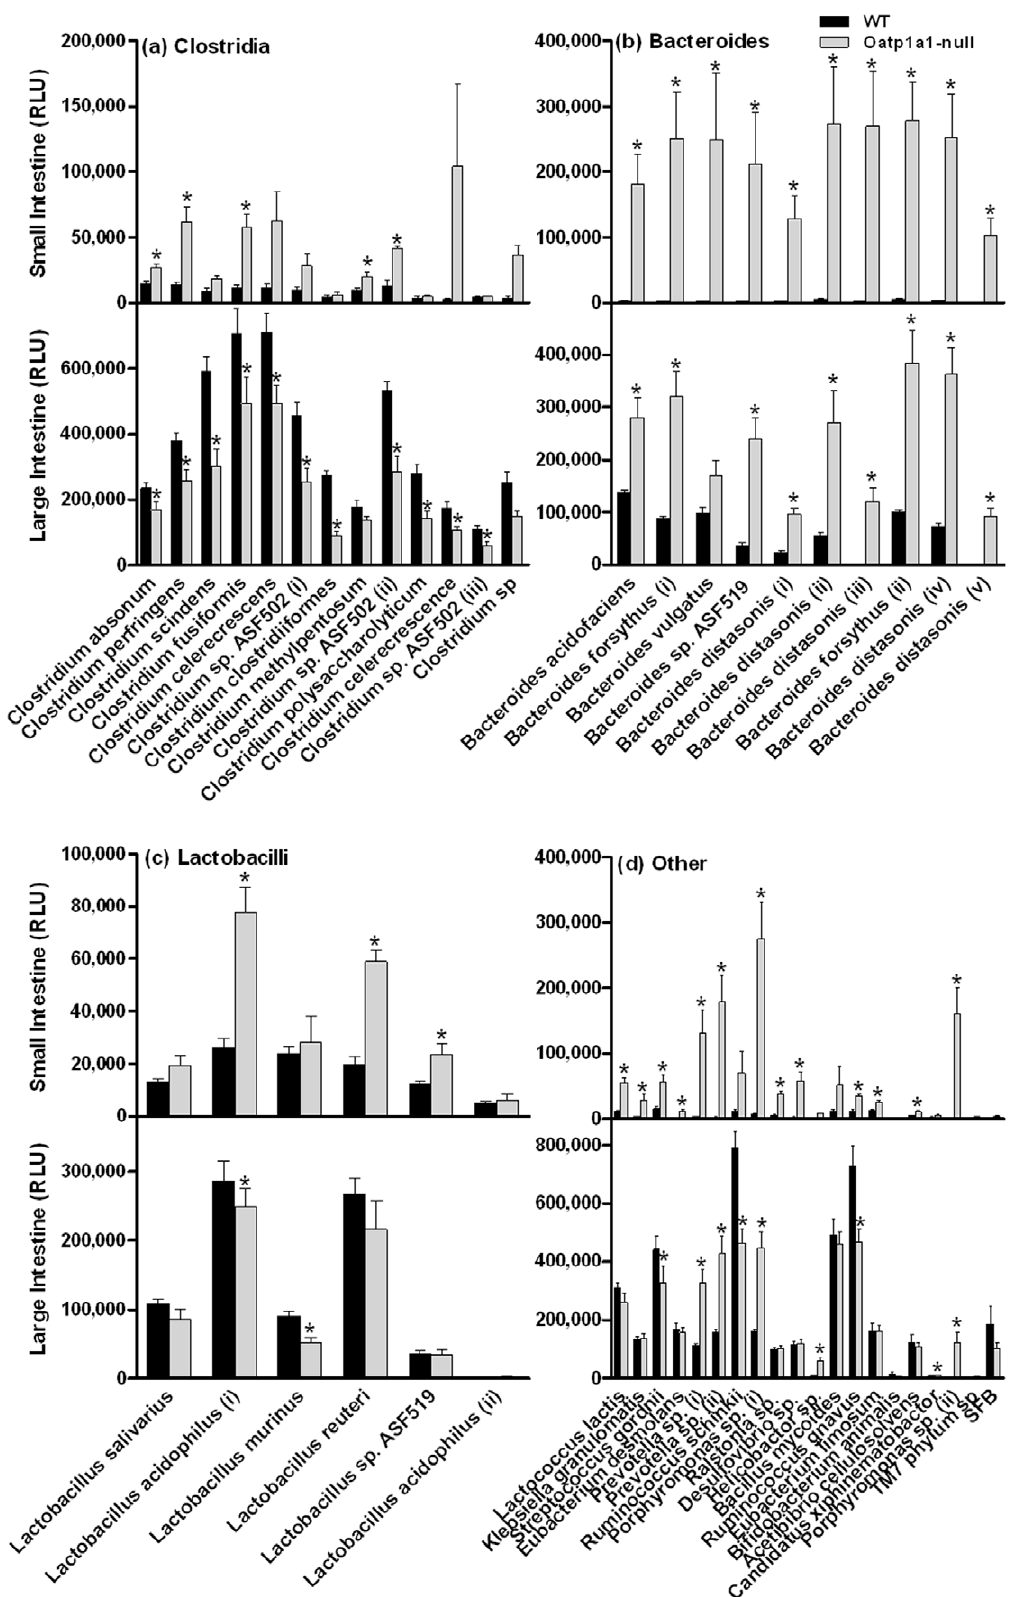
Figure 5. Small and large intestinal bacteria in WT and Oatp1a1-null mice. Clostridia (a), Bacteroides (b), Lactobacilli (c), and other bacteria (d) in the small and large intestinal contents of WT and Oatp1a1-null mice were quantified using a branched DNA assay (Panomics/Affymetrix,